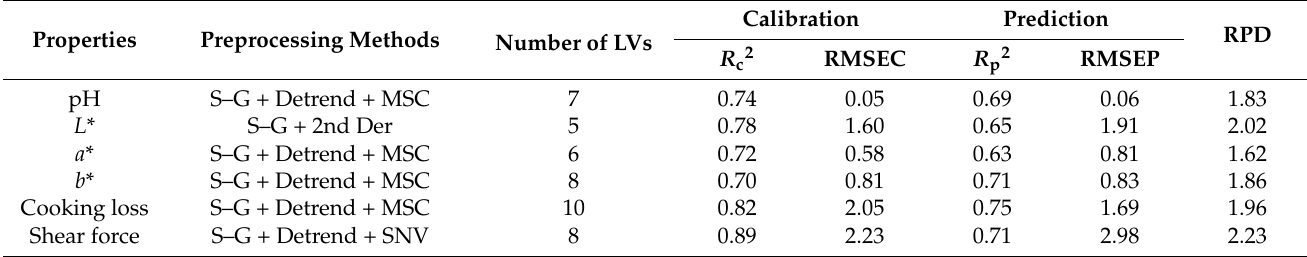
Table 5. The comparison result of PLSR models established based on carcass division for the combined meat cuts.